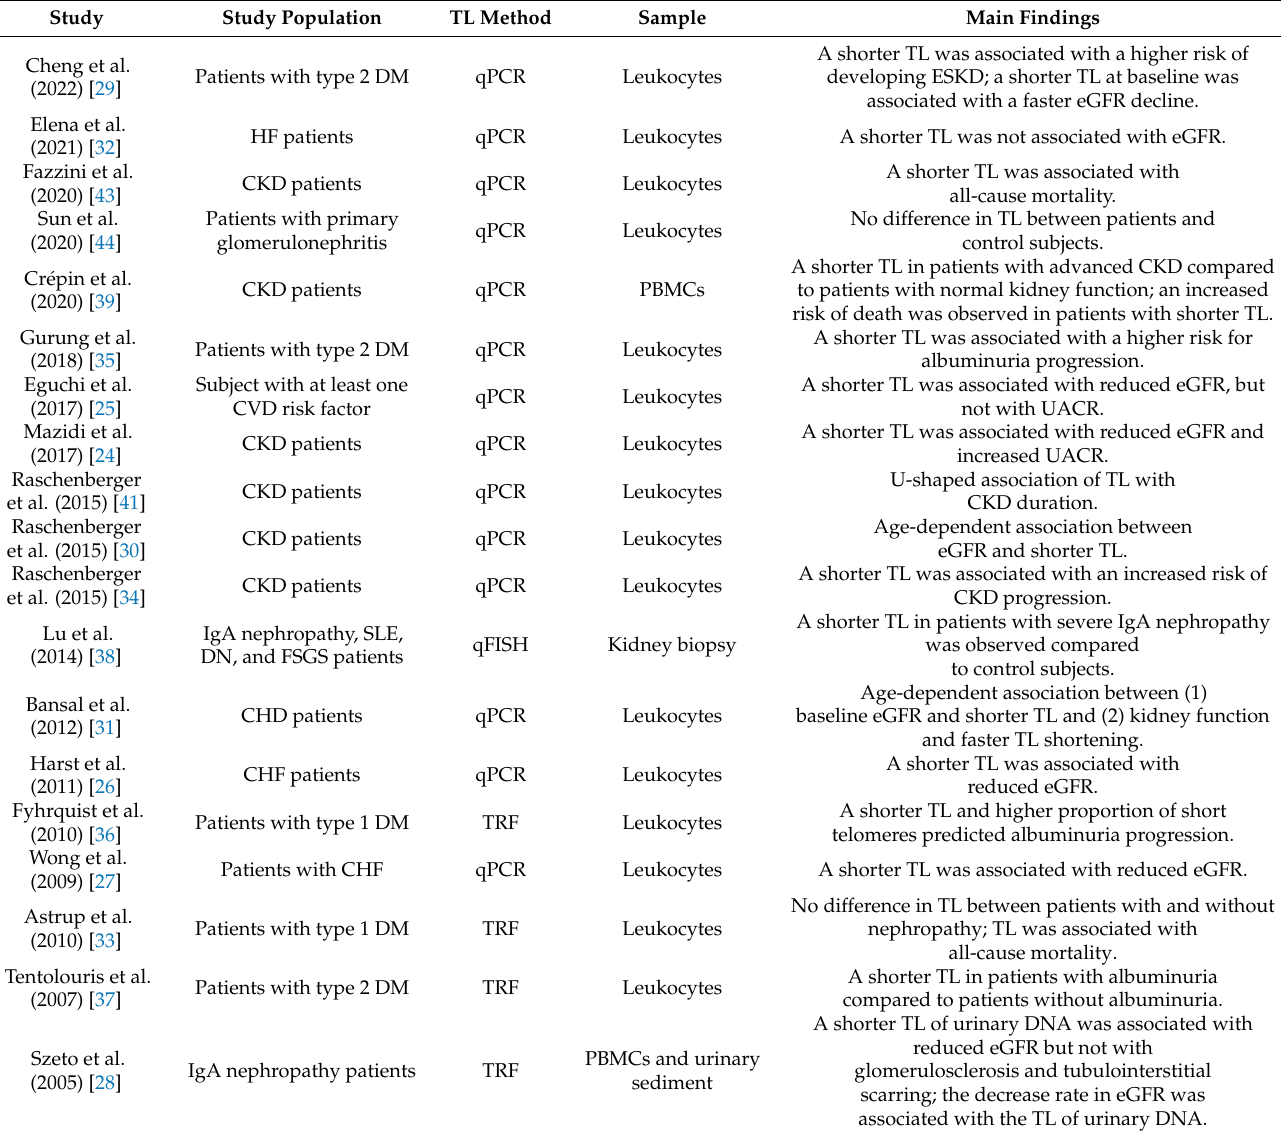
Table 1. Studies on telomere length in chronic kidney